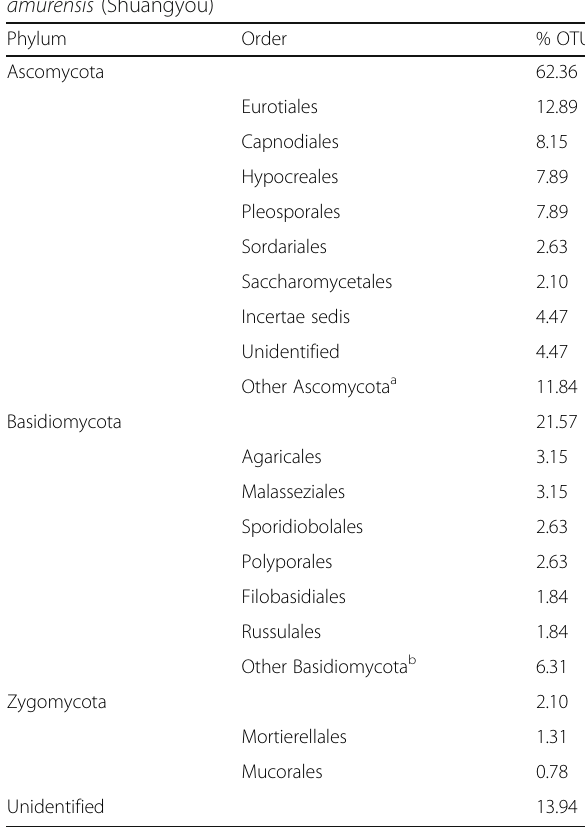
Table 1 Taxonomic distribution of OTUs making up phyla and orders of endophytic fungi in V . vinifera (Red Globe) and V